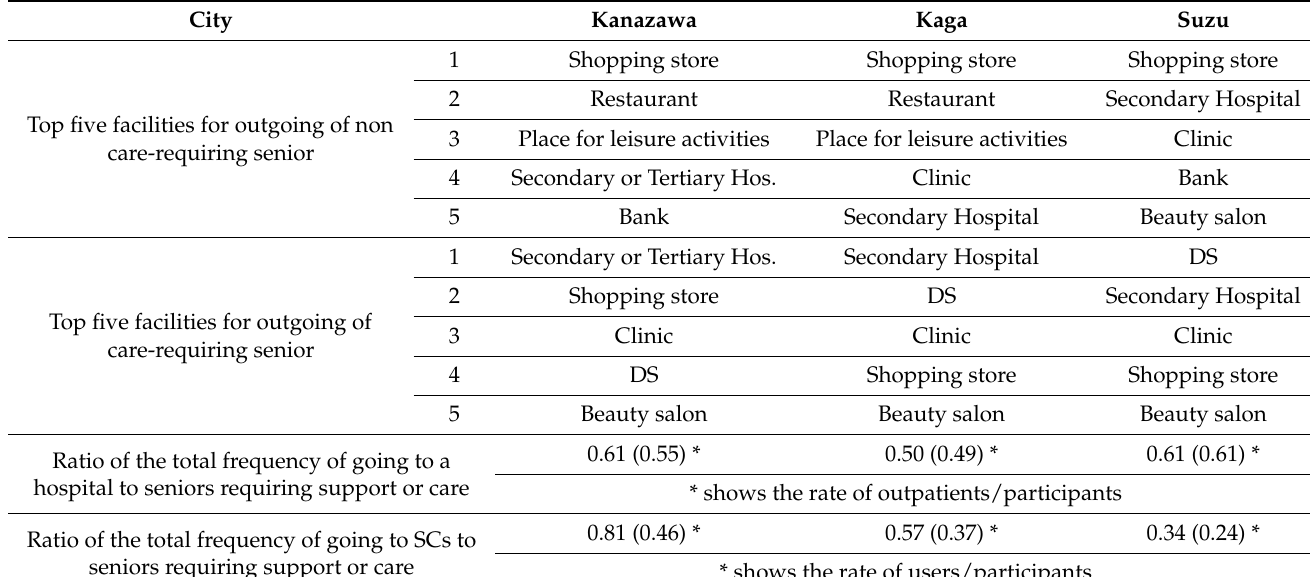
Table 5. Five major factors that extended outing distances of participants in three cities.